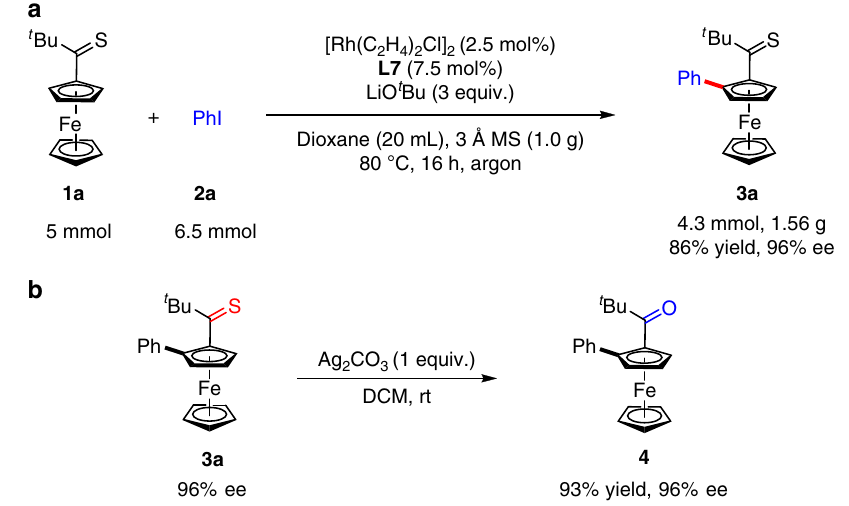
Fig. 2 Gram-scale reaction and transformation. a Arylation of 1a on a 1.56 g scale. b Oxidation of thioketone